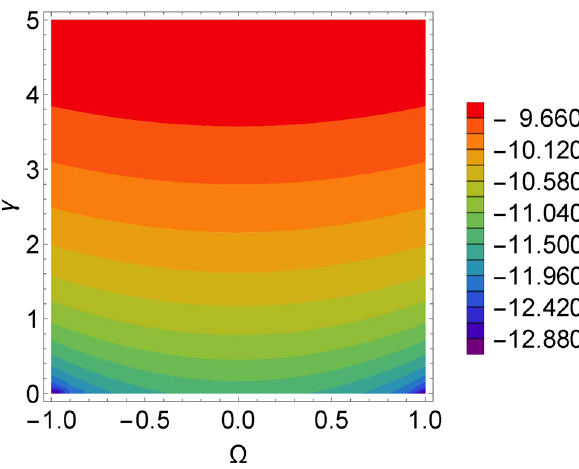
Fig. 5 Free energy (cid:8) T F , (23) for T = 5 for the potential (56) in the parameter space Ω − γ . We have chosen for the lattice spacing a = 1